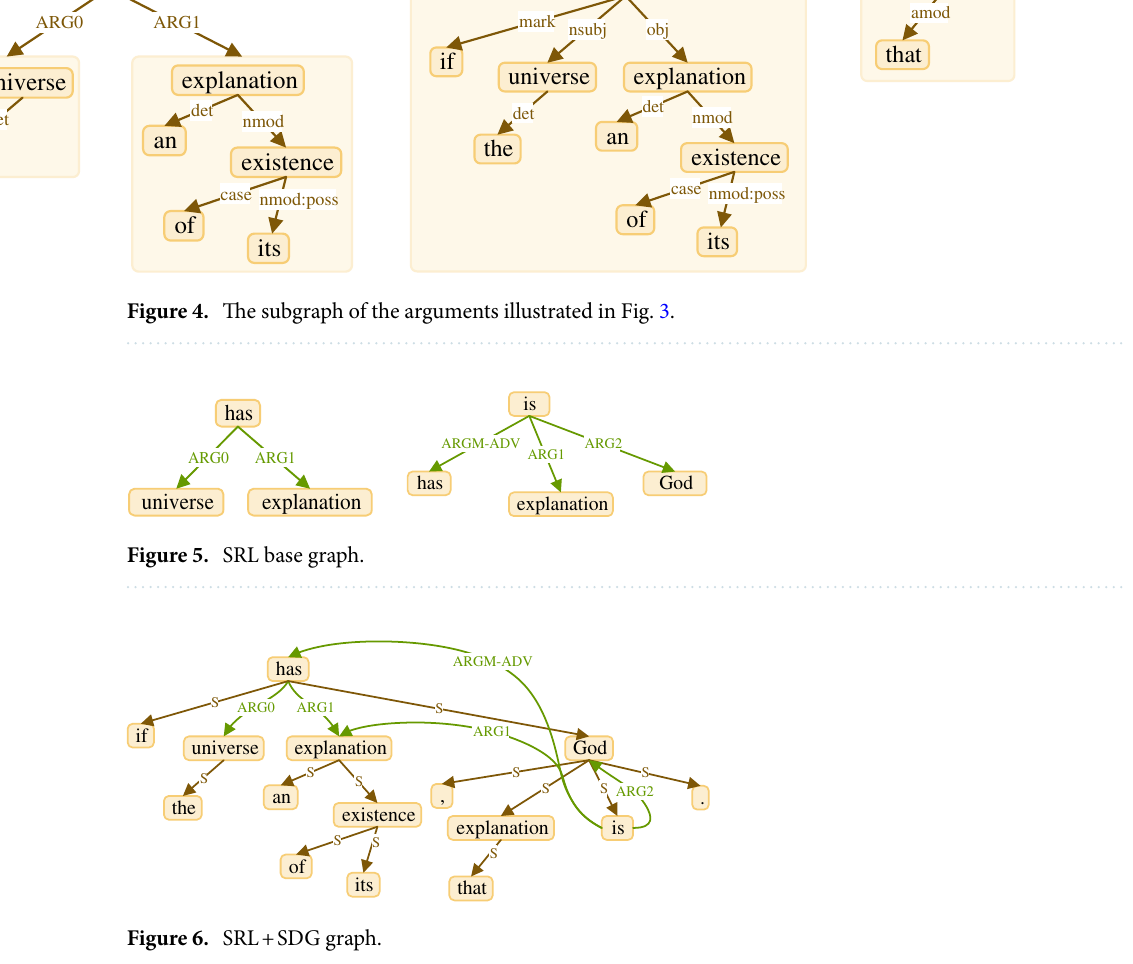
Figure 6. SRL + SDG